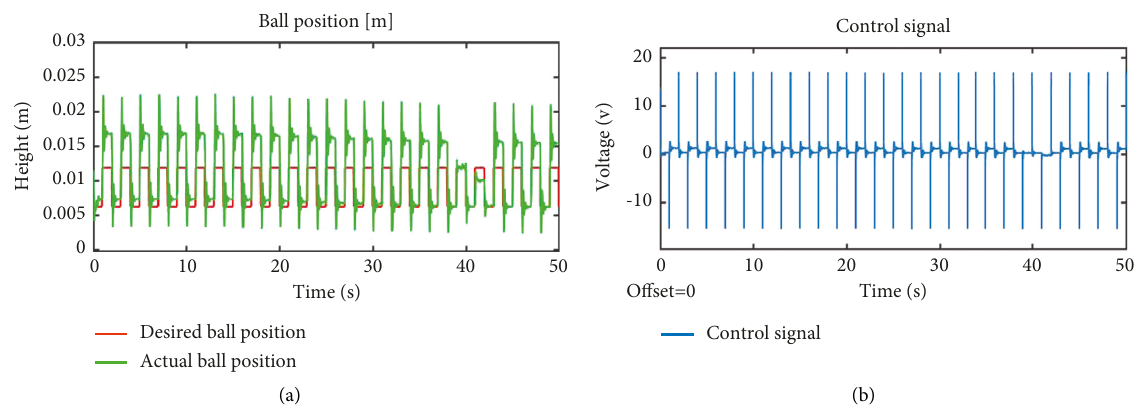
Figure 5: SQUARE output and control signal for the PID controller.